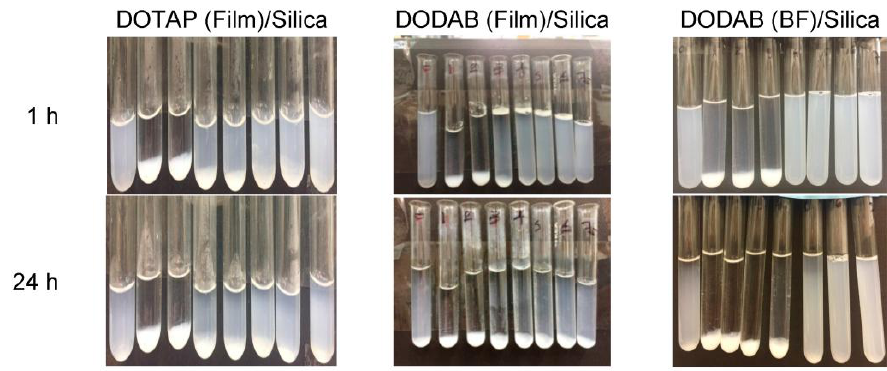
Figure 3. Colloidal stability of silica/cationic lipid dispersions in 1 mM KCl solution over a range of DODAB or DOTAP concentrations at 2 mg/mL silica. DOTAP or DODAB concentrations were 0, 0.05, 0.1, 0.2, 0.3, 0.5, 0.6, and 1.0 mM. BF: Bilayer fragments.